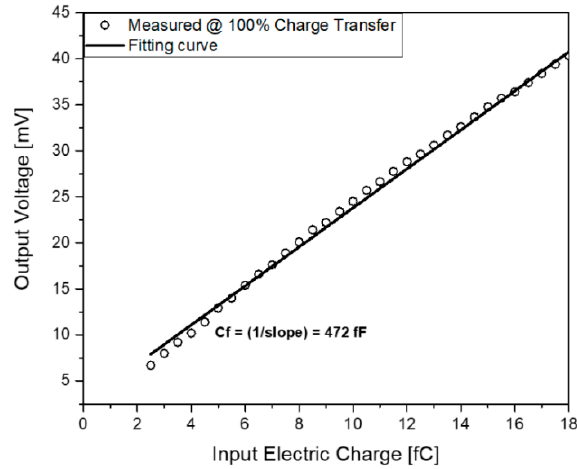
Figure 14. Tested results of the output voltage of the CSA.